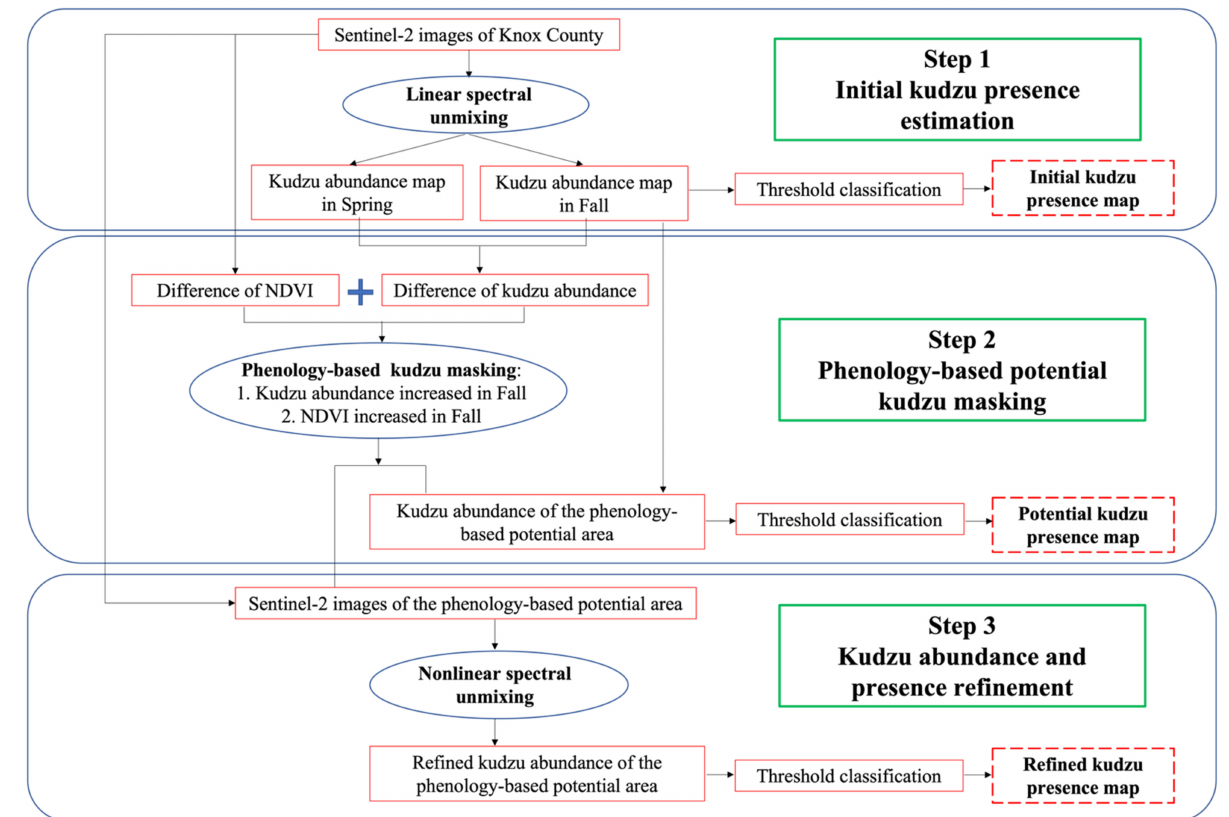
Figure 2. The three steps of the spectral unmixing and phenology-based kudzu identification